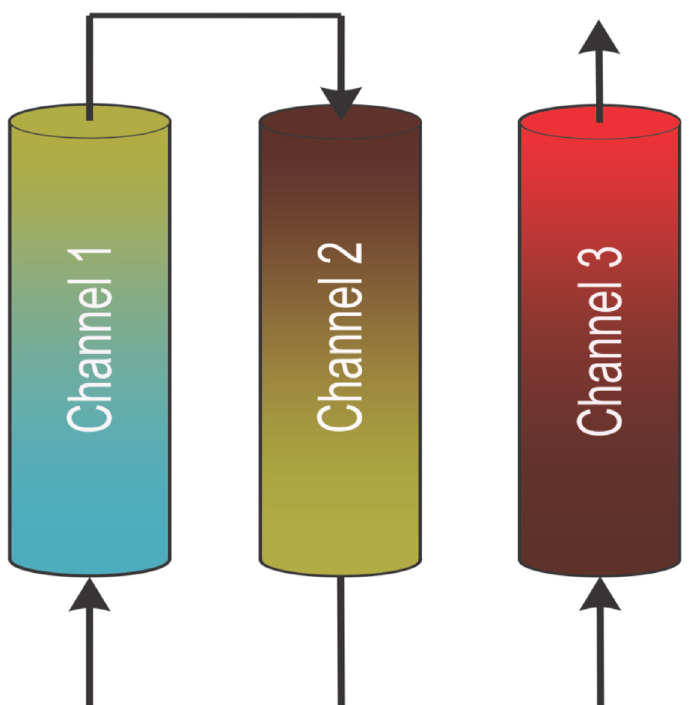
Fig. 6. Arrangement of the computational nodes in the thermal-hydraulics core model of the